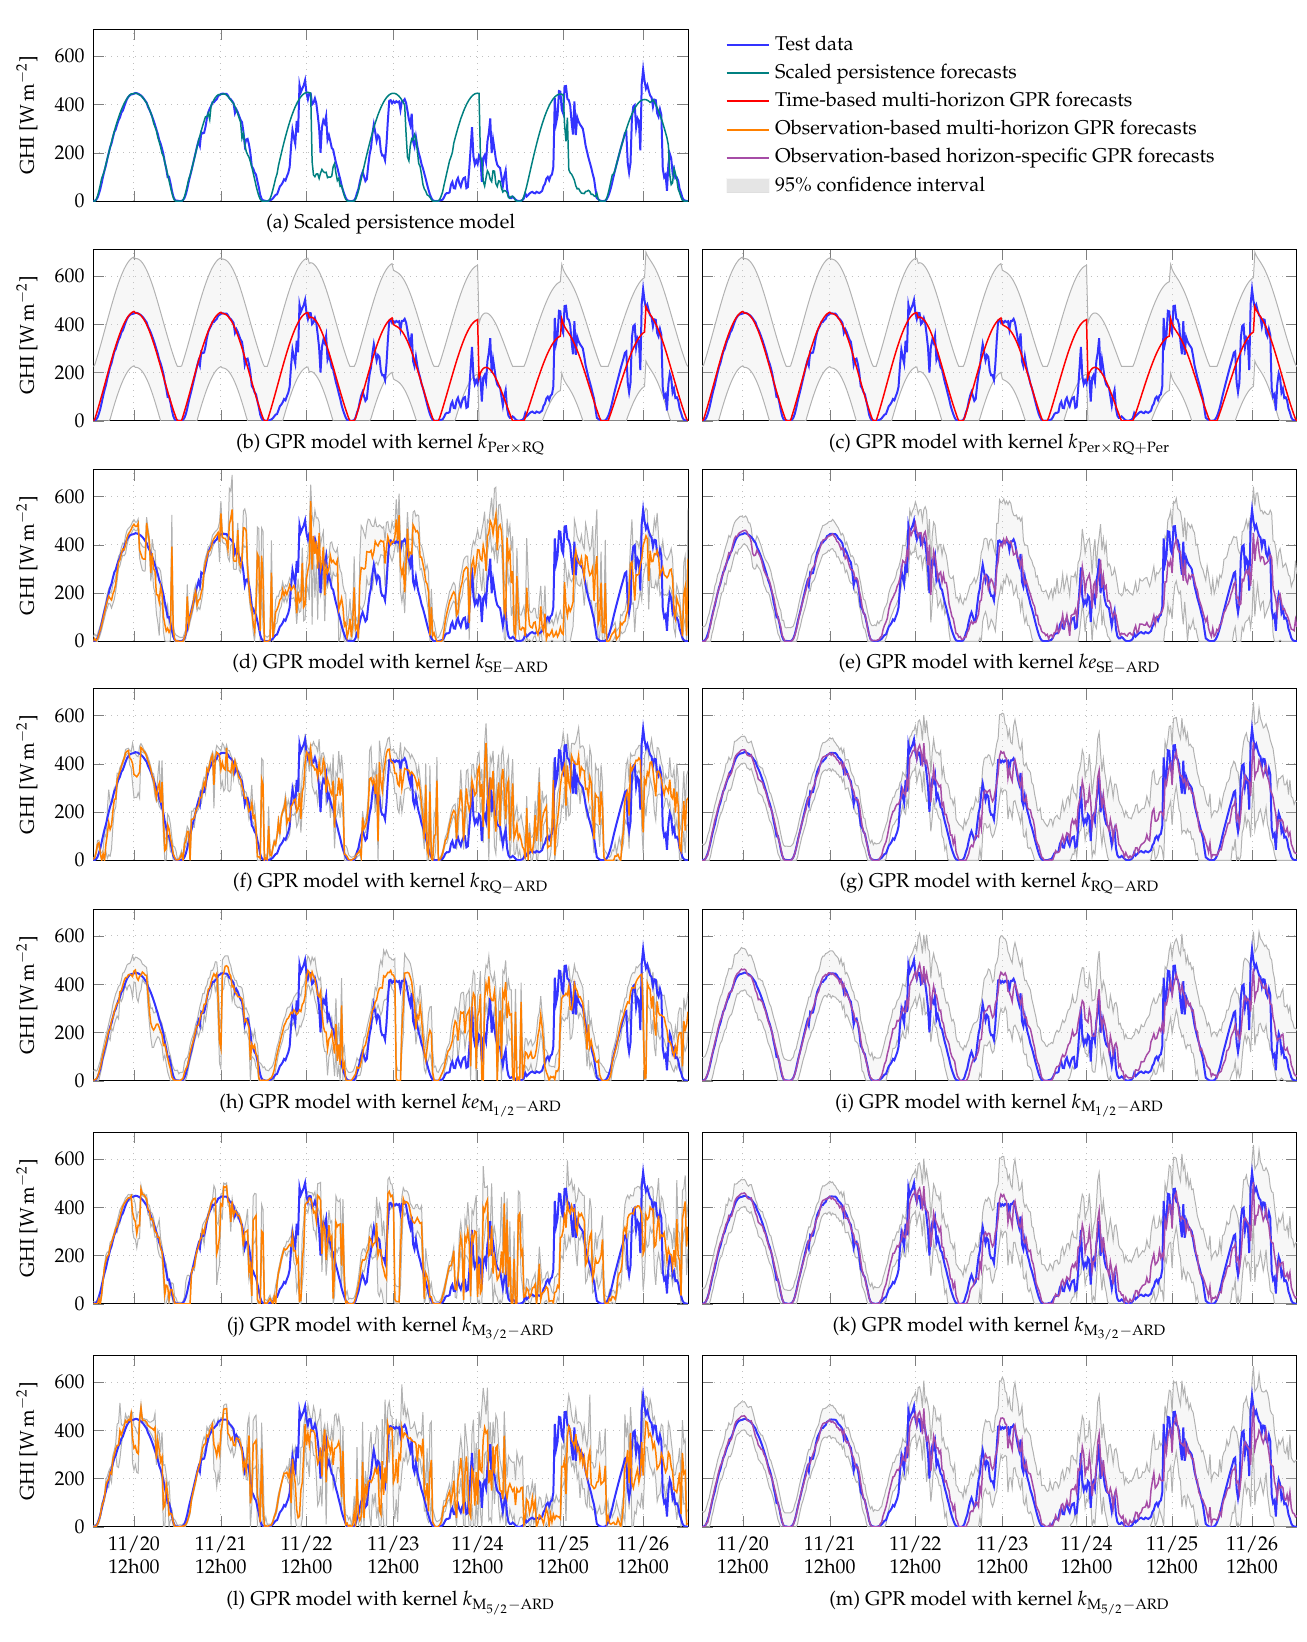
Figure 14. Examples of 5 h GHI forecasts over one week, given by the scaled persistence model and the GPR models included in this